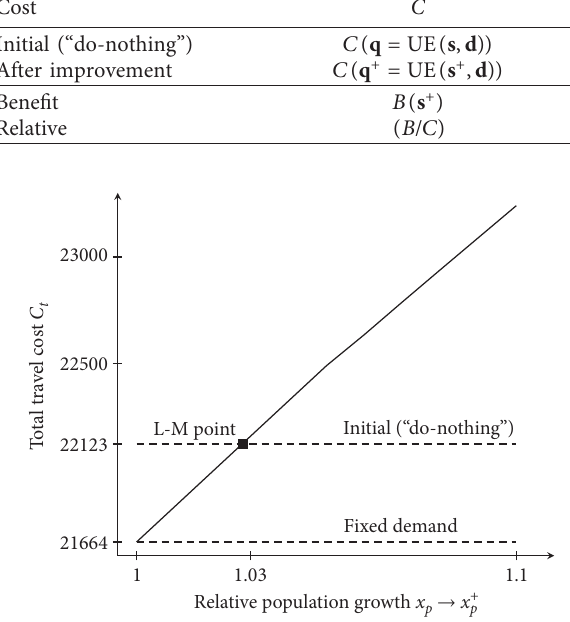
Figure 3: Travel costs C t against population growth.